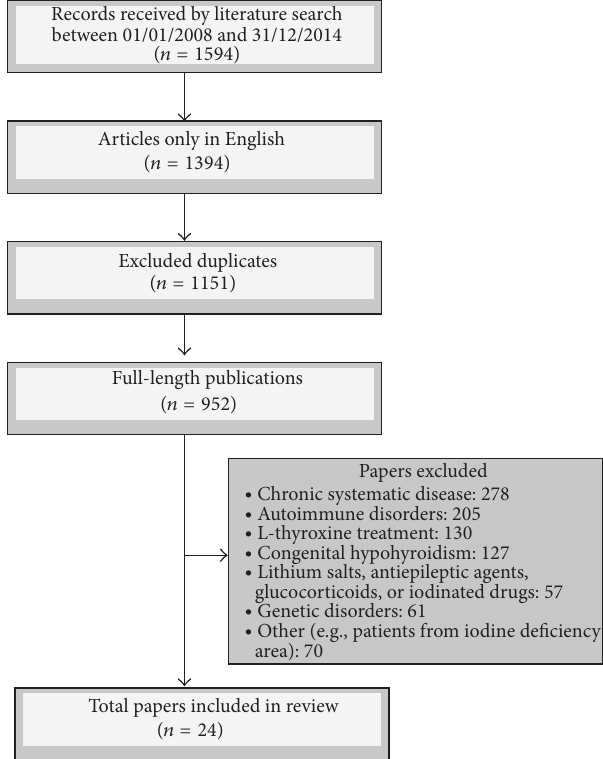
Figure 1: Study design and inclusion/exclusion